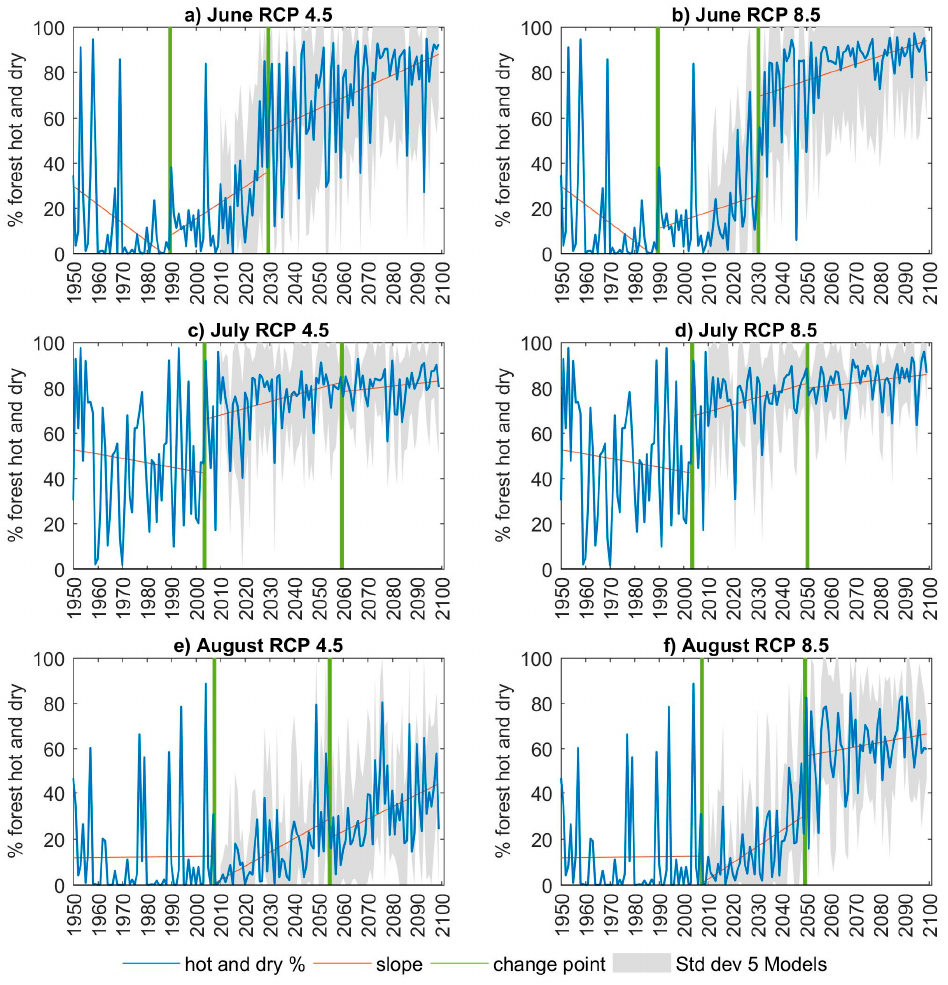
Figure 12. The percentage of forests that are vulnerable (hot and dry) in June, July, and August using historical (1949–2009) and future (2010–2099) climate scenarios. Hot is defined as temperature greater than 13.4 C, and dry is defined as PET > ET. Blue lines show future results for the five-model mean simulations (MM45 and MM85) and gray shading illustrates the standard deviation of the five individual CMIP5 models.